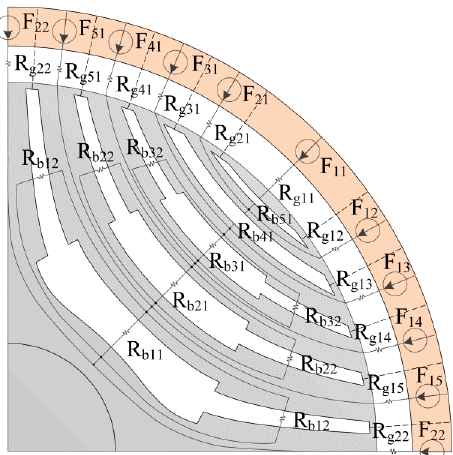
Figure 3. MEC for a SynRM with cross-shaped flux-barriers.